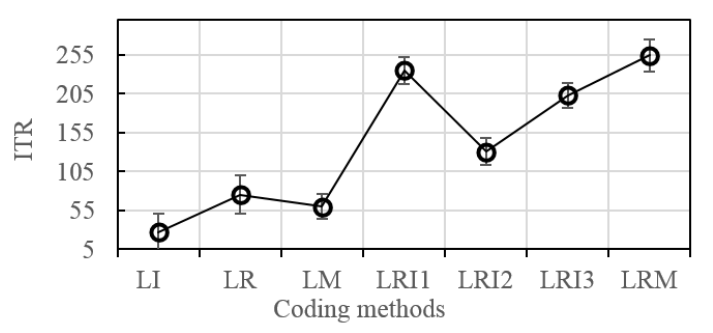
Figure 10. Information transfer rate for different coding methods; the error bars indicate standard error.